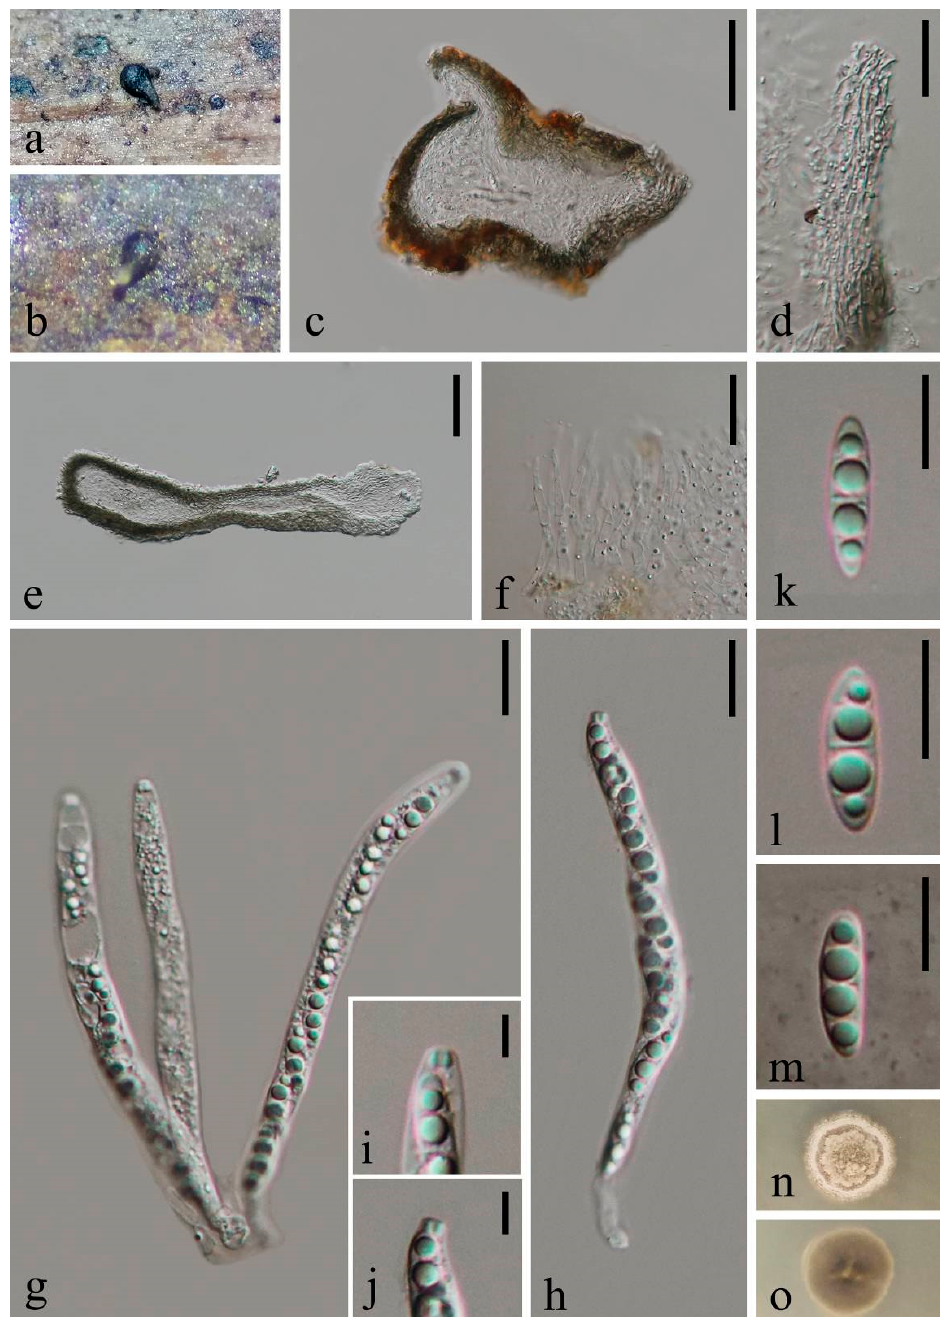
Figure 6. Obliquifusoideum guttulatum (MFLU 18-1575, holotype). ( a , b ) ascomata lying on submerged wood; ( c ) section of ascoma; ( d ) peridium; ( e ) section of neck; ( f ) paraphyses; ( g , h ) unitunicate asci; ( i , j ) apical rings; ( k – m ) ascospoers (m ascospore in Indian Ink); ( n , o ) colony on PDA (up-front, down-reverse). Scale bars, ( c ) 50 μ m; ( d , f ) 20 μ m; ( e ) 30 μ m; ( g , h ) 15 μ m; ( i , j ) 5 μ m; ( k – m ) 10 μ m.